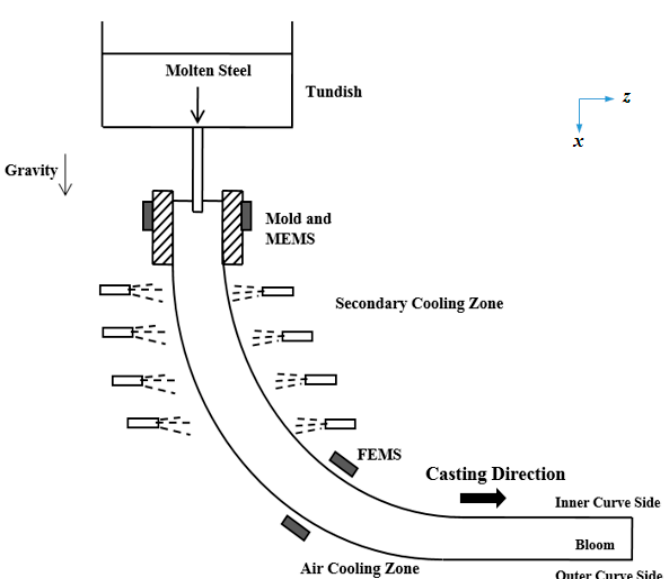
Figure 1. Schematic of curved continuous casting machine: GCr15 molten steel is poured into the mold through the top tundish, then solidifying along the casting direction. The bloom size is 220 mm × 220 mm. MEMS and FEMS are mold and final electromagnetic stirrings, and the conditions of the electromagnetic stirring are the same under different superheats. The sample is obtained by cutting along the transverse section of the bloom after finishing solidification.